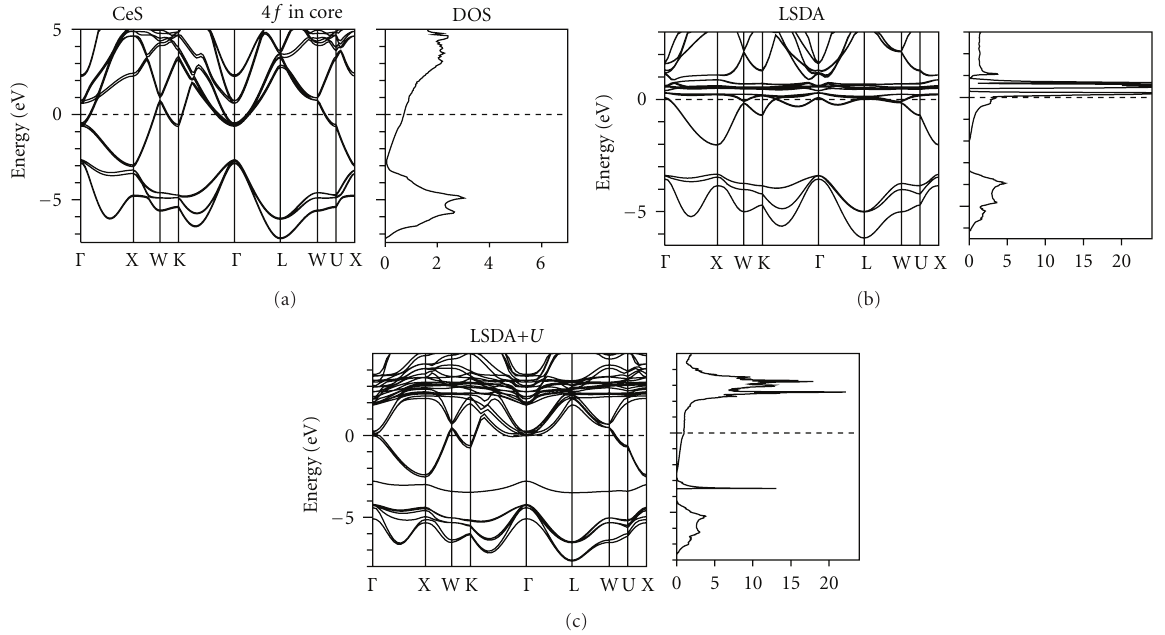
Figure 37: Self-consistent fully relativistic, spin-polarized energy band structure and total DOS (in states/(unit cell eV)) calculated for CeS [261] treating the 4 f states as, (a) fully localized (4 f in core), (b) itinerant (LSDA), and (c) partly localized (LSDA+ U